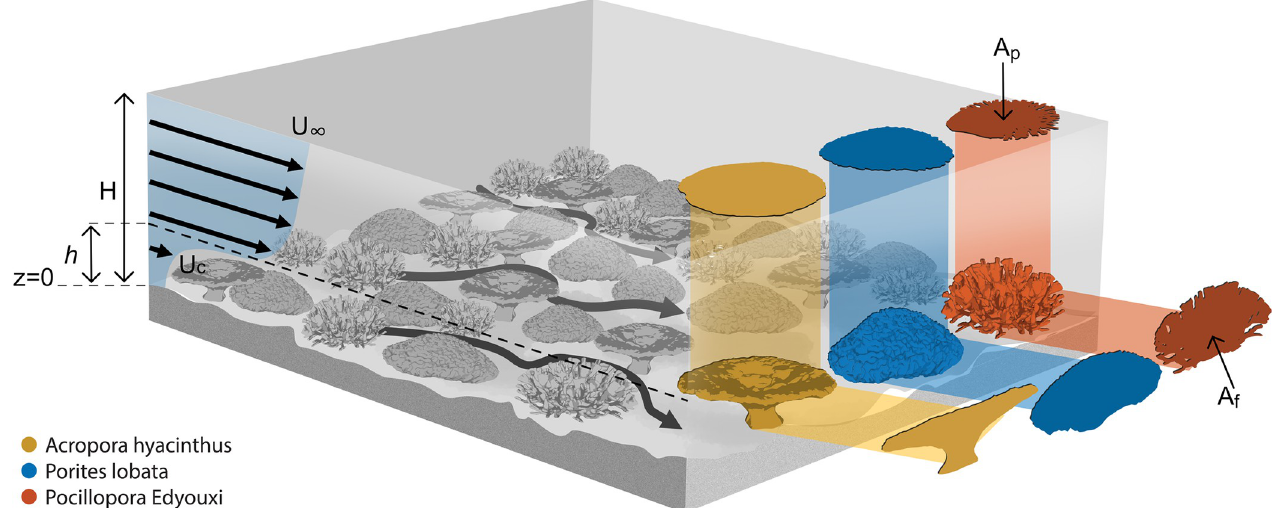
Fig 2. Conceptual model of the flow above and within benthos on a coral reef. For a given water depth ( H ), the near-surface flow velocity ( U 1 ) is greater than that within the reef region ( U ), which is defined by the height of the benthos ( h ) above the seabed. The plan area ( A c the three archetypal coral forms in Fig 1 (“Table”, “Massive” and “Branching”). Note that Af is not simply the total coral area projected into the flow; rather, it is the sum of the projected areas of all coral